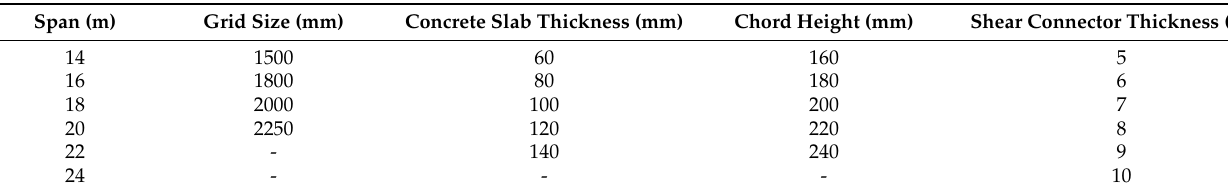
Table 5. Variation range of parameters.